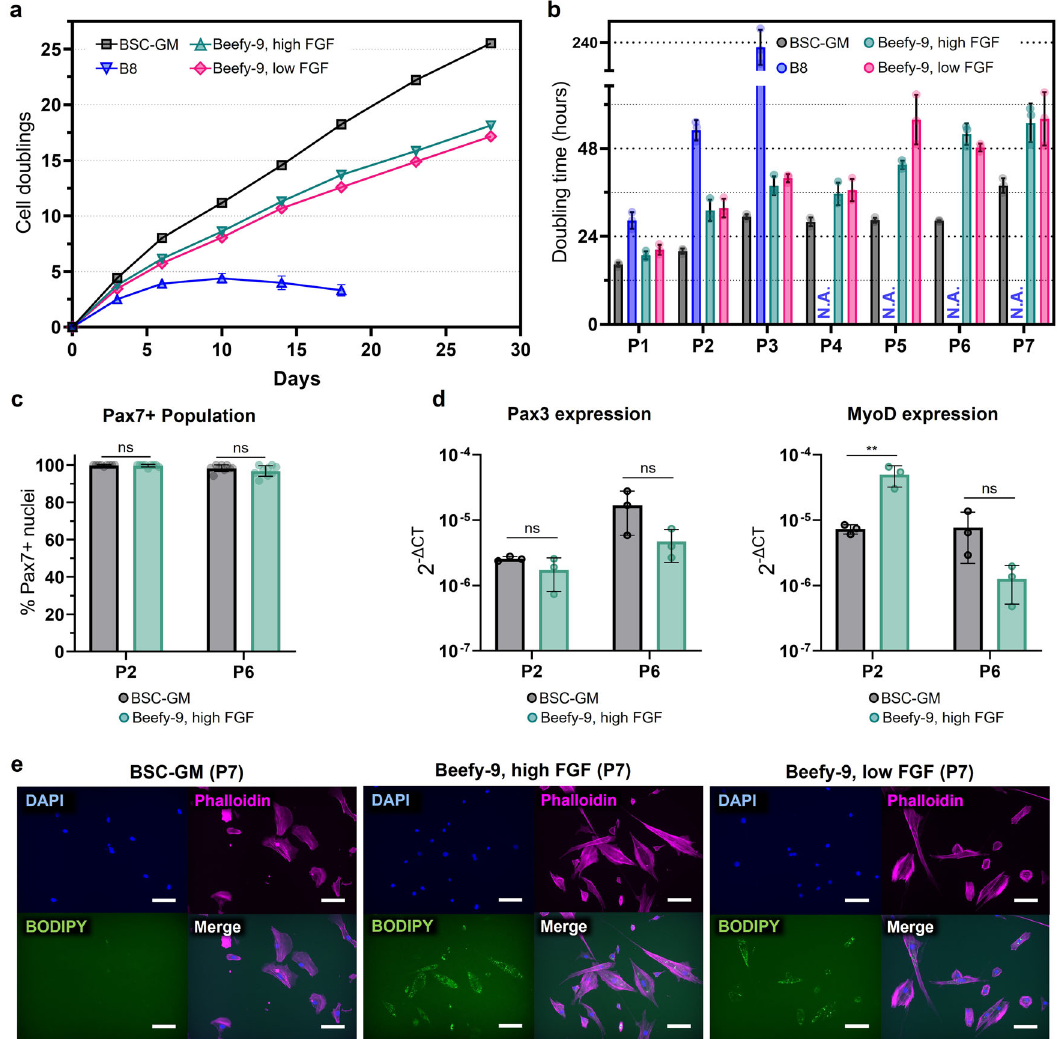
Fig. 5 Long-term culture. a Cell doublings over multiple passages of BSCs cultured in BSC-GM, B8, Beefy-9, high FGF (40 ng/mL FGF-2), or Beefy-9, low FGF (5 ng/mL FGF-2). Results show that the addition of rAlbumin signi fi cantly improved cell growth in B8 over four weeks, although not to the degree of serum. Reducing Beefy-9 FGF-2 decreased cell doublings compared to 40 ng/mL, although this difference was less substantial (17.2 doublings vs 18.2 doublings at 28 days). n = 6 (two counts for three biological replicates), and error bars are given as ±standard deviation (though in some instances are smaller than the sample icons). b Doubling times were calculated over long-term culture and compared between media. An increase in doubling time at higher passages was found, particularly for Beefy-9 with high or low FGF-2. Notably, however, doubling times remained <48 h for the fi rst fi ve passages (~13 doublings) in Beefy-9 with high FGF-2. c Analysis of Pax7 staining (Fig. S5) shows that the percentage of Pax7 + nuclei stayed above 96% for at least six passages in both serum and serum-free media. No signi fi cant difference in the percent of Pax7 + cells is observed between media types ( n = 9 distinct samples, calculated via two-way ANOVA with multiple comparisons between media types). d Quantitative PCRs for Pax3 and MyoD expression in proliferative cells grown in BSC-GM and Beefy-9 show no signi fi cant differences between media types, except in the case of P2 MyoD, where Beefy-9 shows higher expression than BSC-GM. Results are supported by immuno fl uorescent staining for these markers (Fig. S5). n = 3 distinct samples; statistical signi fi cance was calculated via two-way ANOVA with multiple comparisons between media and is indicated by asterisks in which p < 0.01 (**). e BODIPY staining of lipid accumulation in P7 cells cultured in various media. Cells were passaged, allowed to adhere overnight, and stained for nuclei (DAPI, blue), actin (Phalloidin, magenta), and lipids (BODIPY, green). Results show increased lipid accumulation in in serum-free media compared to BSC-GM. Scale bars 50 μ